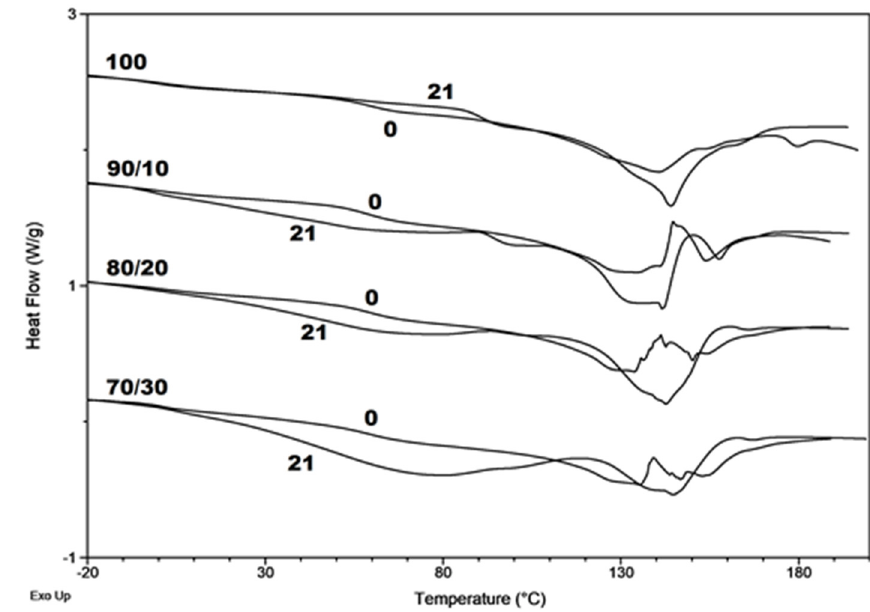
Figure 4. Selected differential scanning calorimetry (DSC) curves (first heating run) for the neat P(3HB- co -4HB) (100/0) and P(3HB- co -4HB)/WF composites with the mass ratio of 90/10, 80/20, and 70/30, before (0) and after 21 days degradation in water (21).